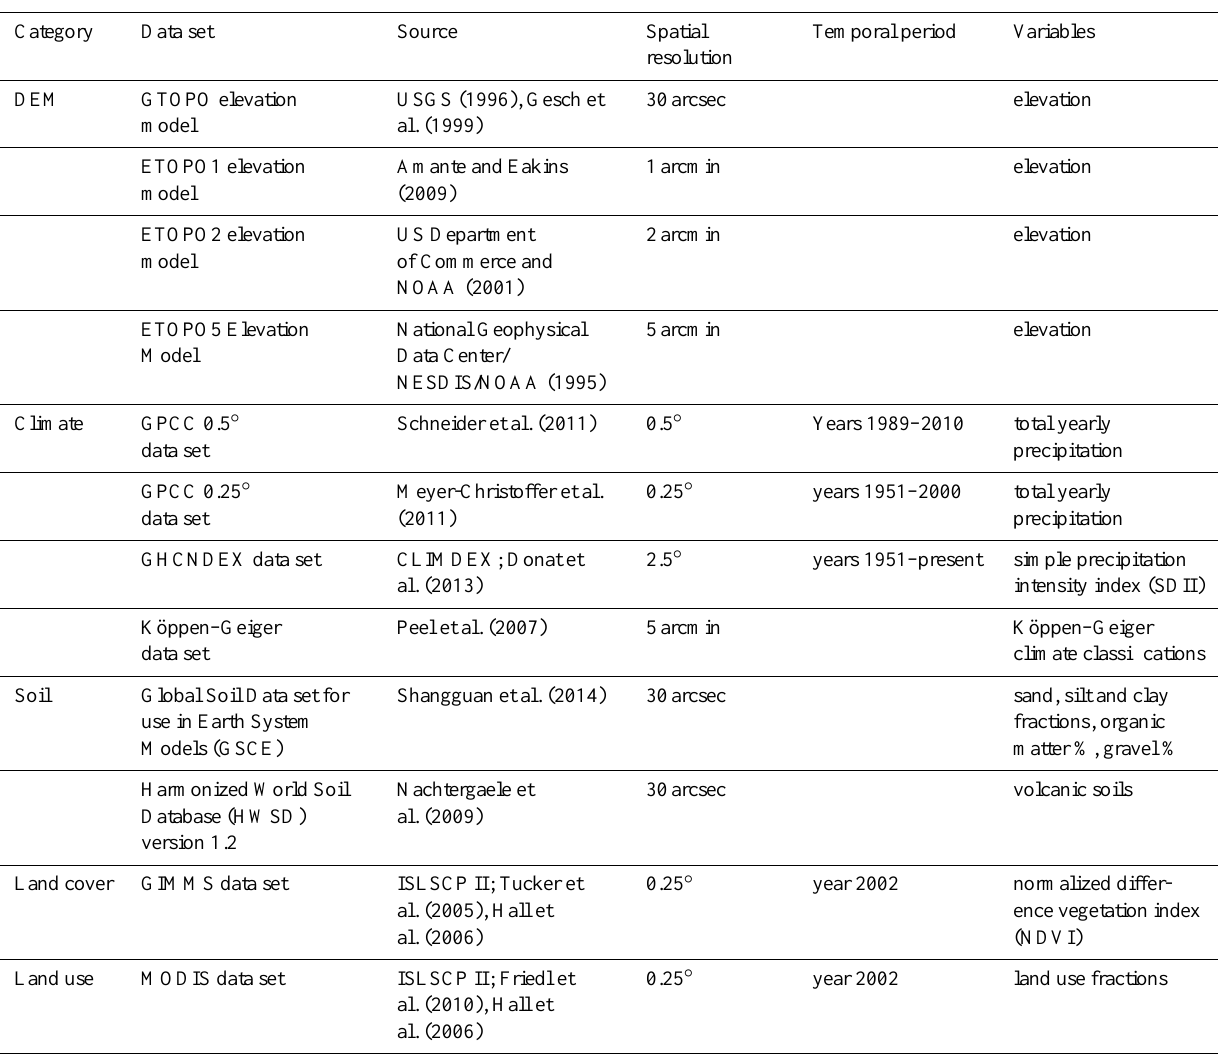
Table 1. List of data sets used in this study.